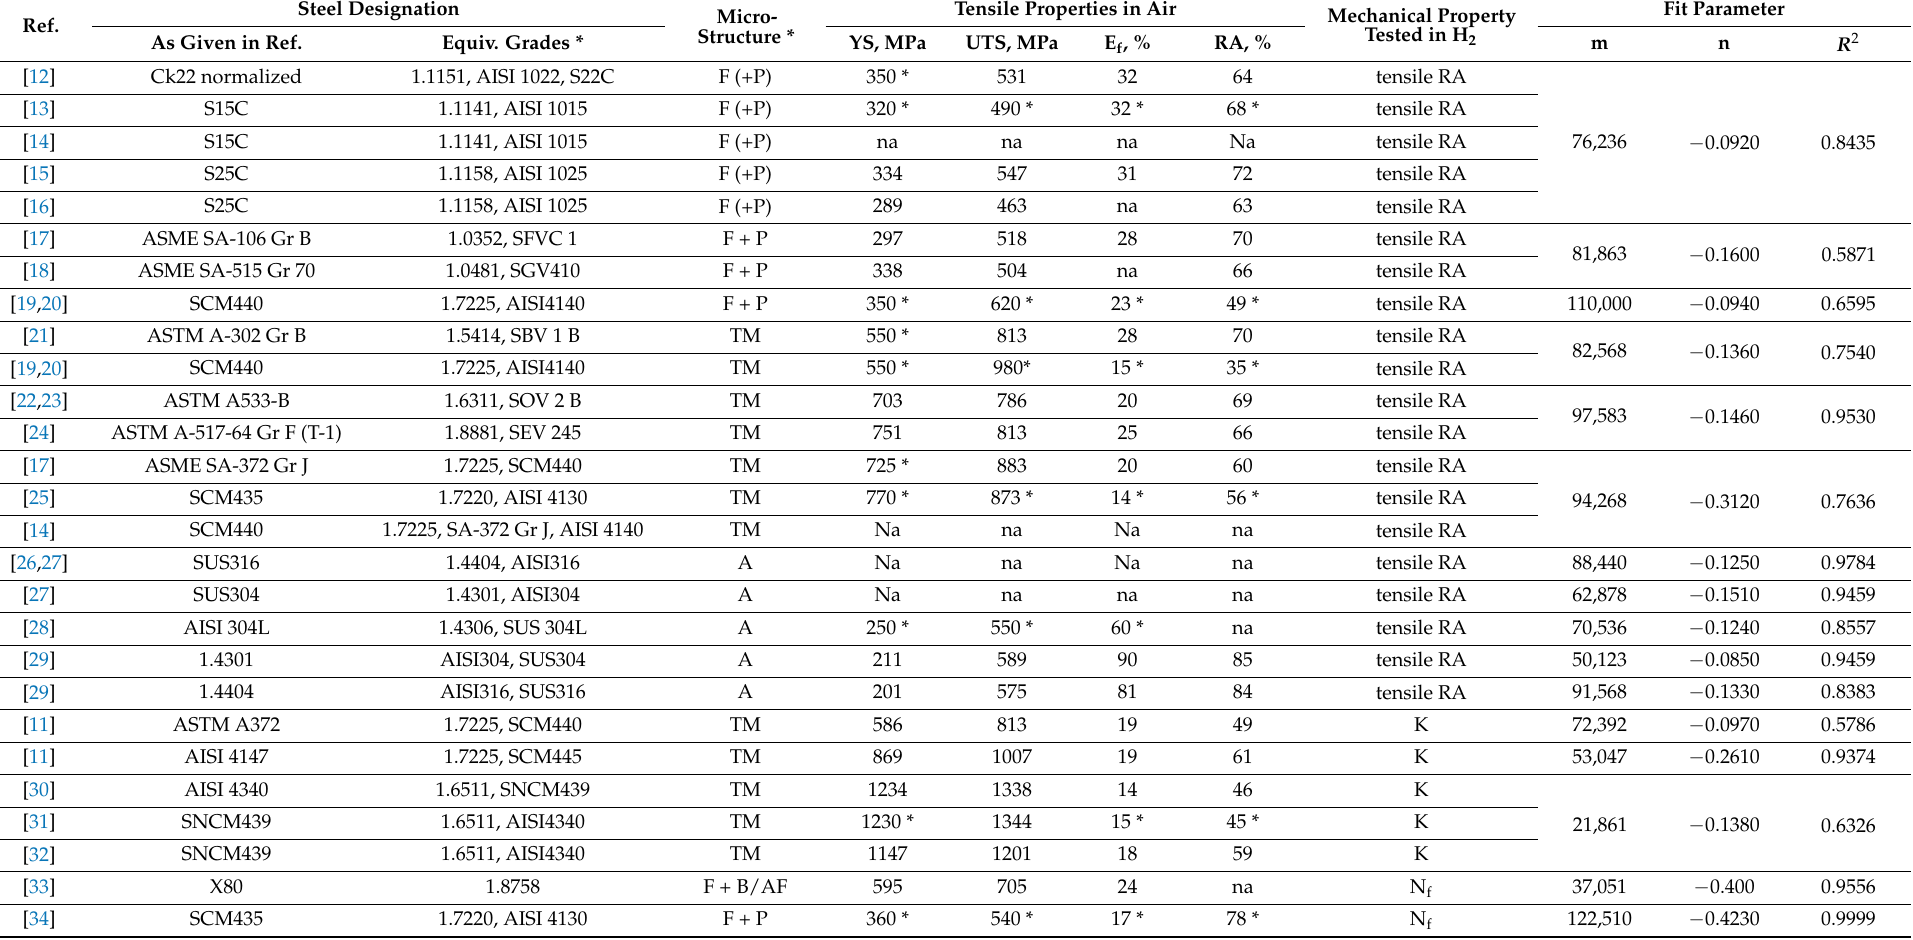
Table 1. Steel designations, similar grades for other regions and mechanical properties of the steels reviewed in this study. Normal letters refer to data explicitly given in the respective reference. (*) refers to data which were estimated from graphs or heat treatment conditions given in the respective references. F = ferrite, P = pearlite, TM = tempered martensite, B = bainite, AF = acicular ferrite. N f = number of cycles to failure in Wöhler-type fatigue life tests, K = fracture toughness, da/dN = crack growth rate, na = not annotated. Ref. As Given in